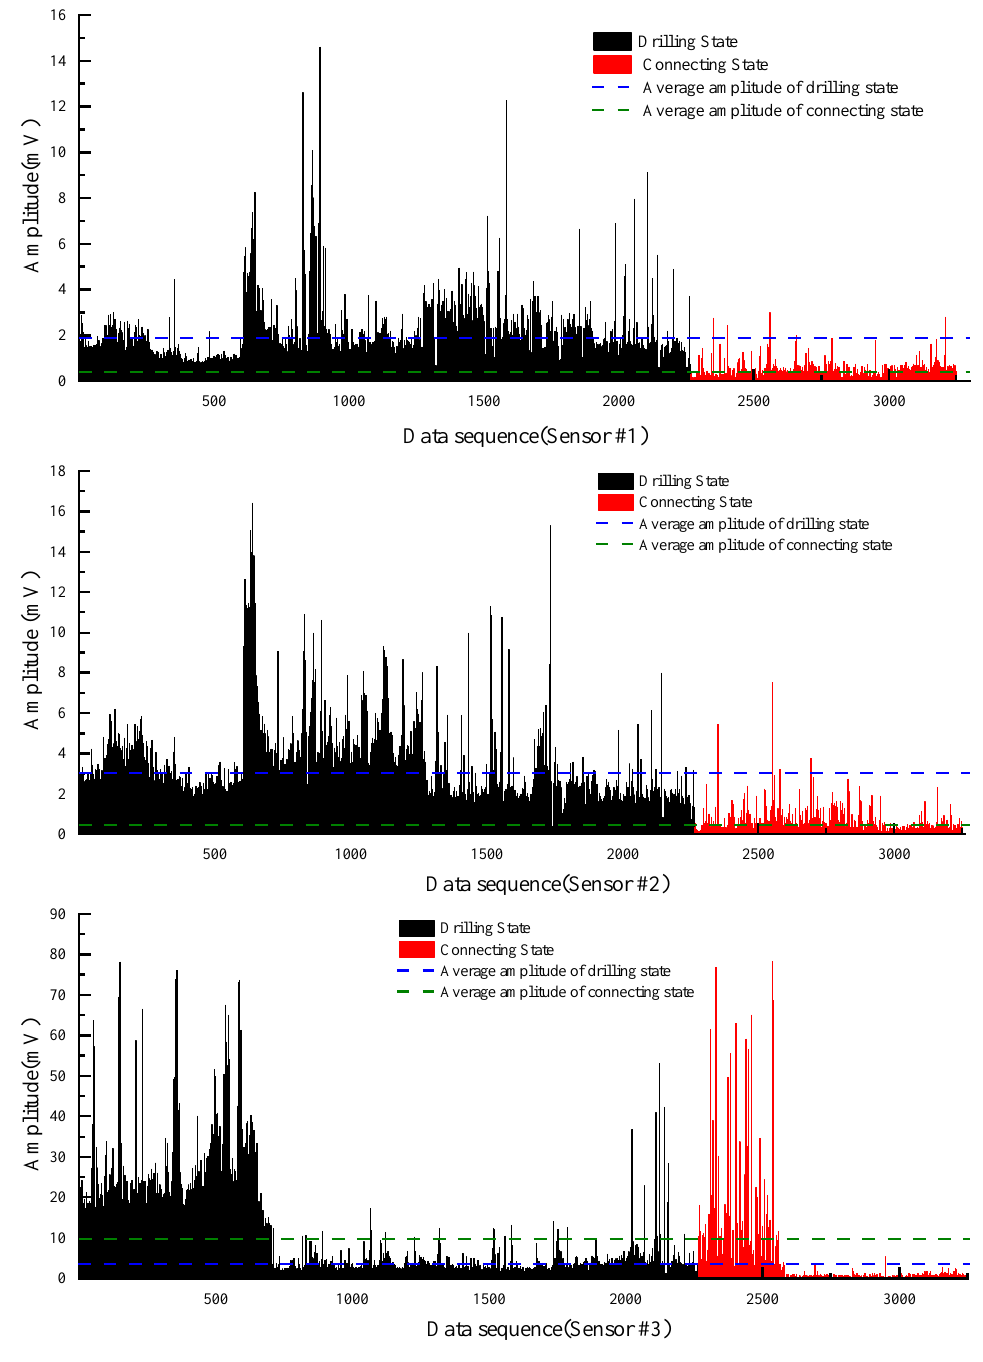
Figure 7. Separability of the two states.